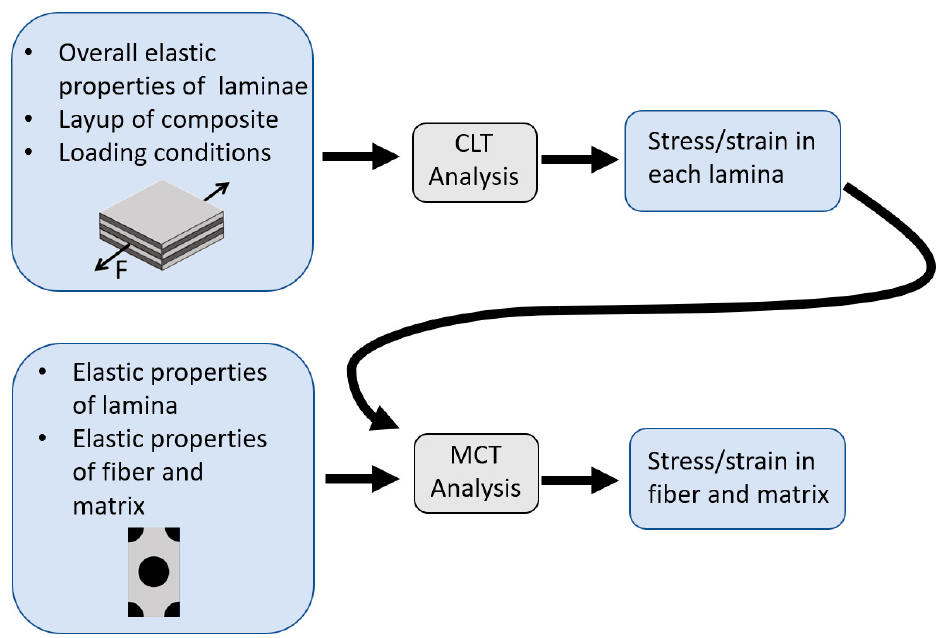
Figure 2. Flowchart depicting the two-level process of failure analysis in composite laminate employing classical laminate theory in conjunction with multicontinuum theory.